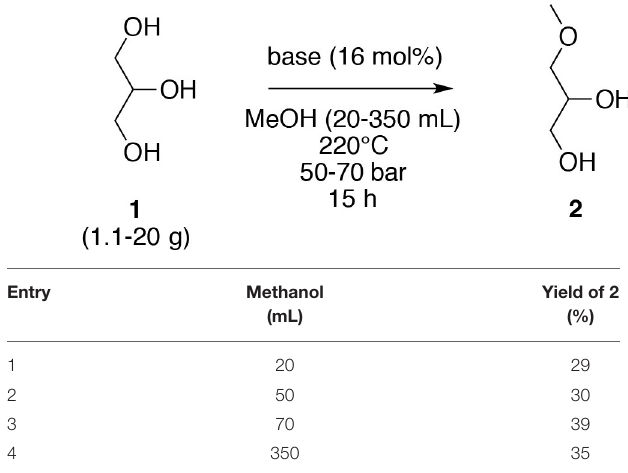
TABLE 5 | Scale down and scale up study for the O -methylation of glycerol ( 1 ) in subcritical